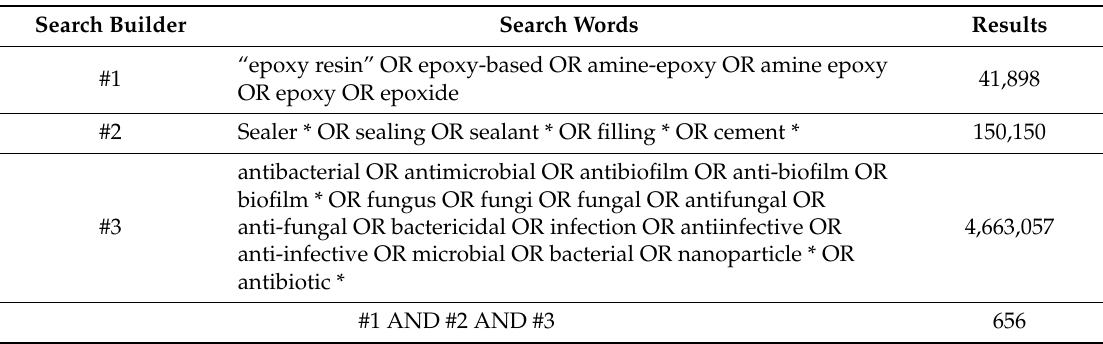
Table 1. Search strategy with the keywords used in the PubMed database.